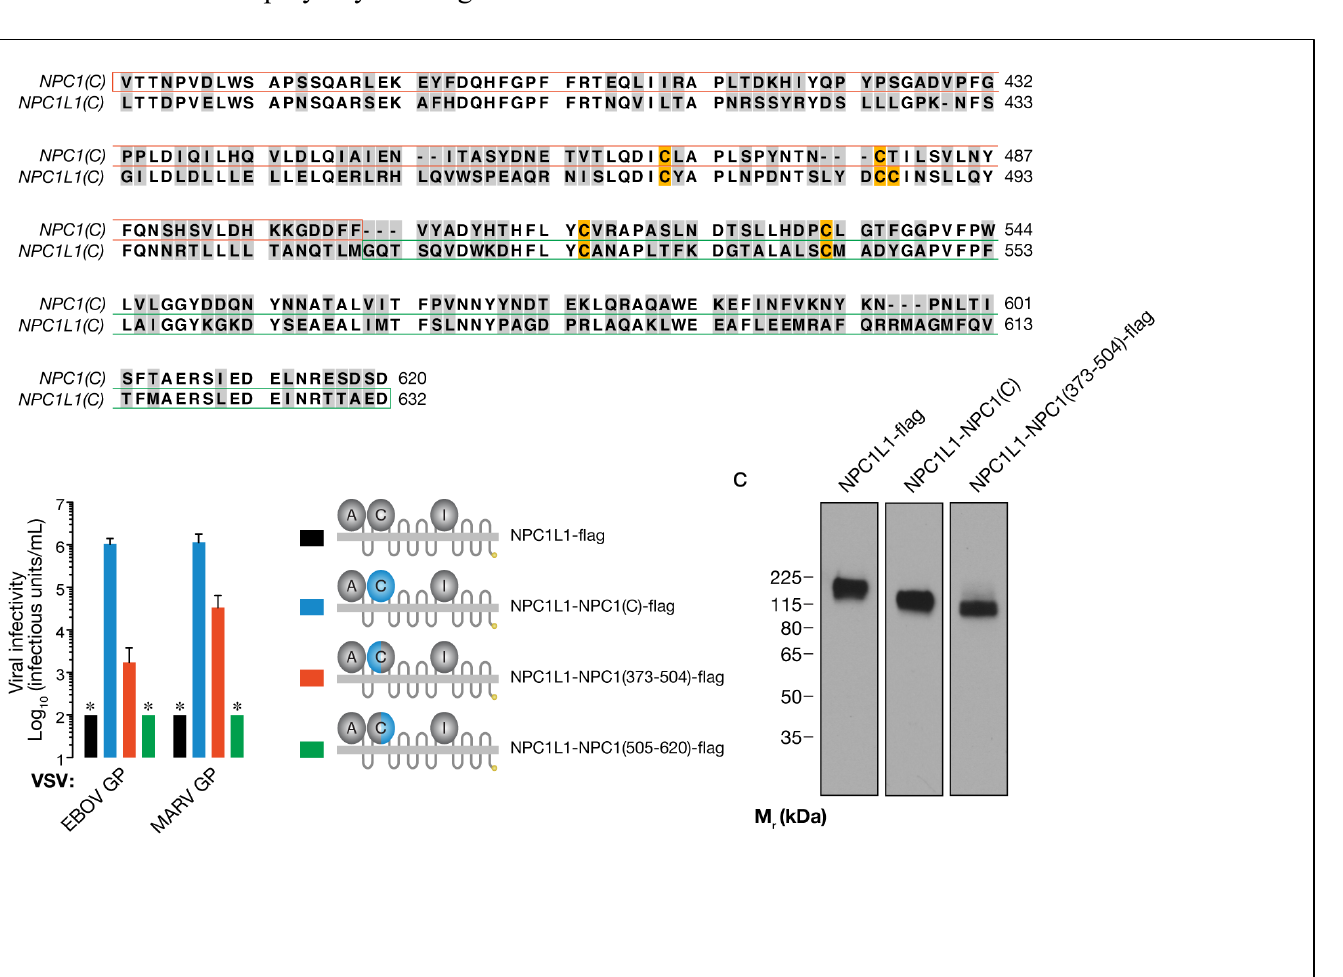
Figure 4. N-terminal sequences from NPC1 domain C render NPC1L1 competent to mediate filovirus entry. (a) Alignment of domain C amino acid sequences from human NPC1 and NPC1L1. Sequence differences are shaded in gray. Sequences exchanged between domains are outlined in red and green. Cysteines are highlighted in yellow. (b) Infection of CT43